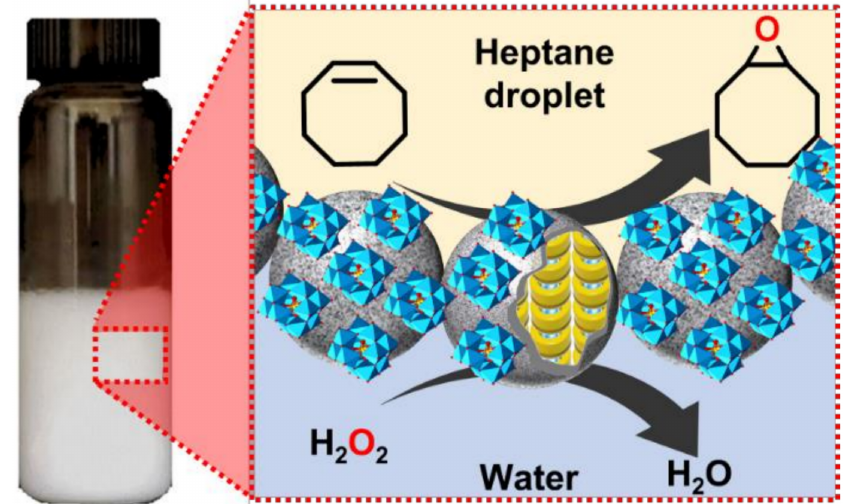
Figure 61. A schematic representation of cyclooctene epoxidation in a heptane-in-water